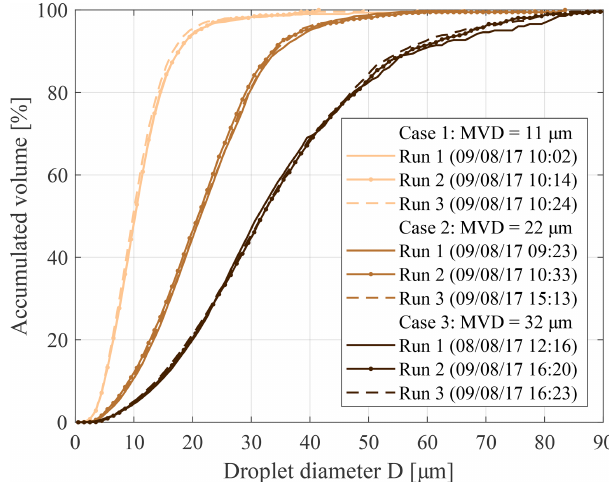
Figure 5. Wind tunnel repeatability shown with PDI measurements at 40ms − 1 , correlation coefficients R 2 . Case 1: Run 1–2, R 2 = 1; Run 1–3, R 2 = 0,999; Run 2–3, R 2 = 0 . 999. Case 2: Run 1–2, R 2